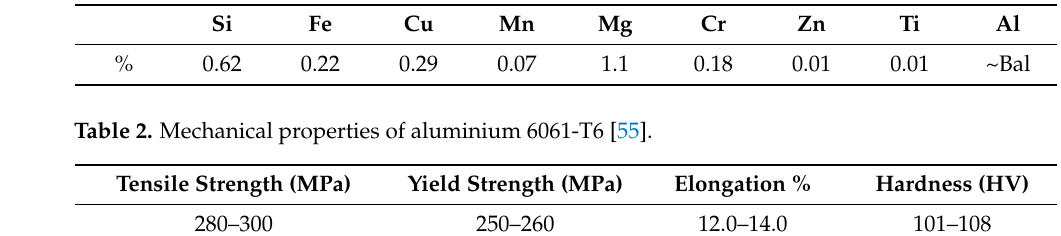
Table 1. Chemical composition of aluminium 6061-T6 [55].